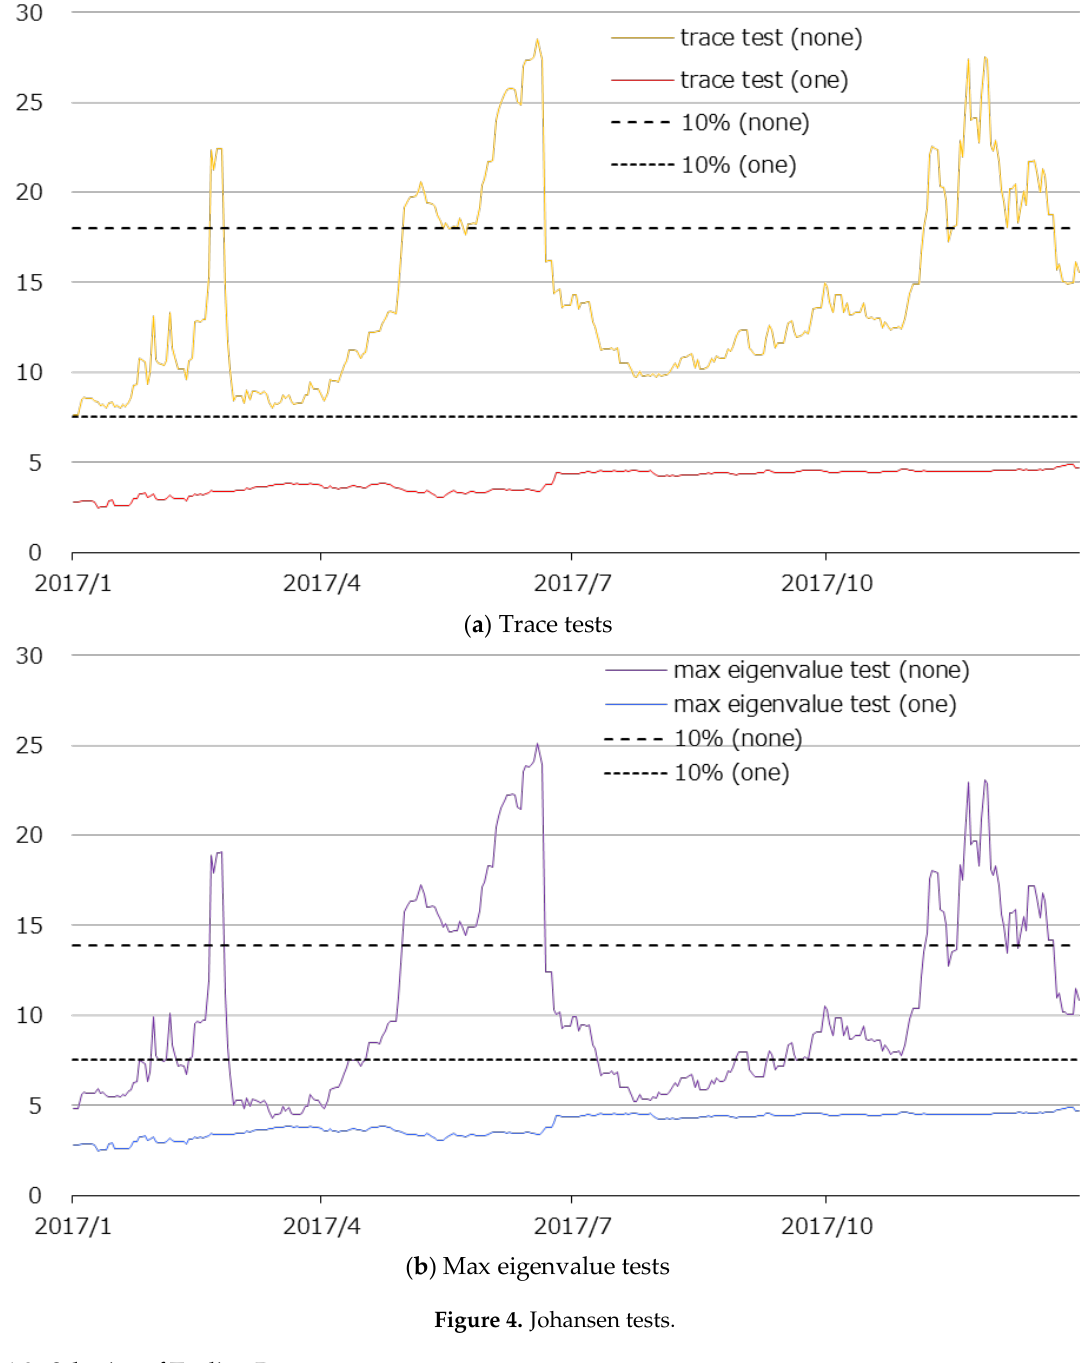
Figure 4. Johansen tests.